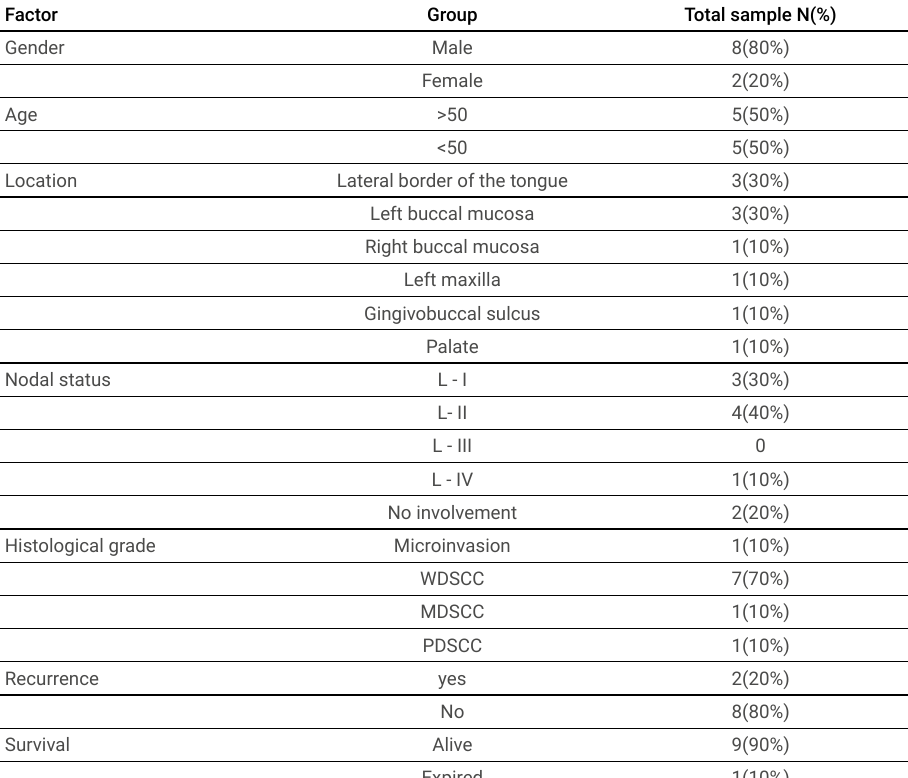
Table 2. Table depicting the demographics, tumour characteristics and the overall survival of the patients included in the